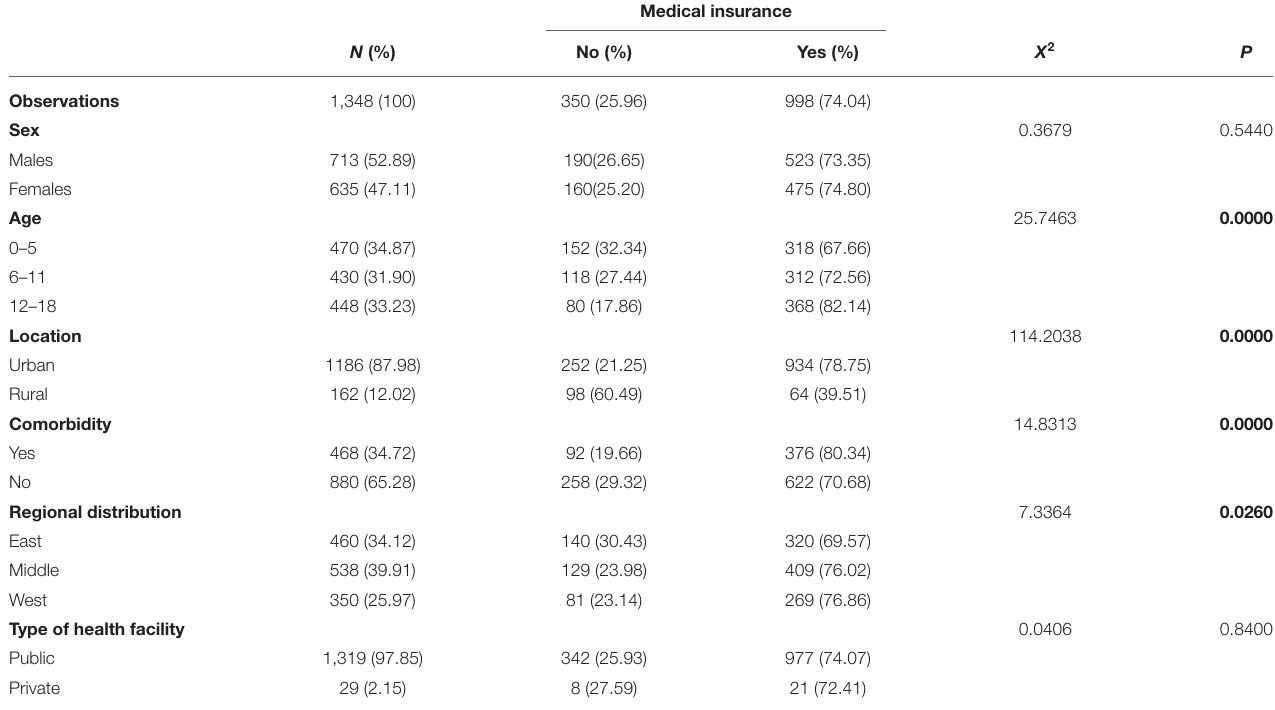
TABLE 1 | Baseline and demographic characteristics.